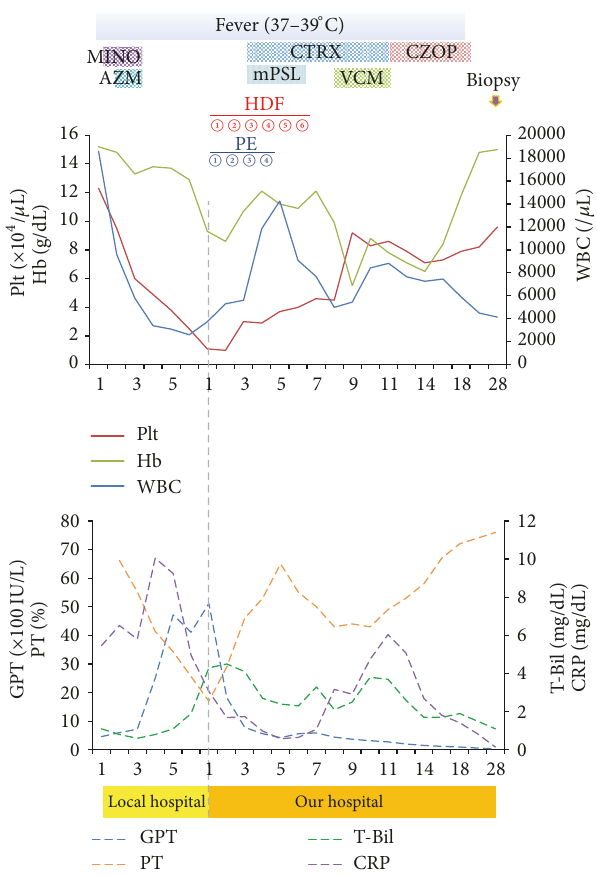
Figure 2: The patient’s clinical course. MINO: minocycline, AZM: azithromycin, CTRX: ceftriaxone, VCM: vancomycin, CZOP: cefo- zopran; mPSL: methylprednisolone sodium